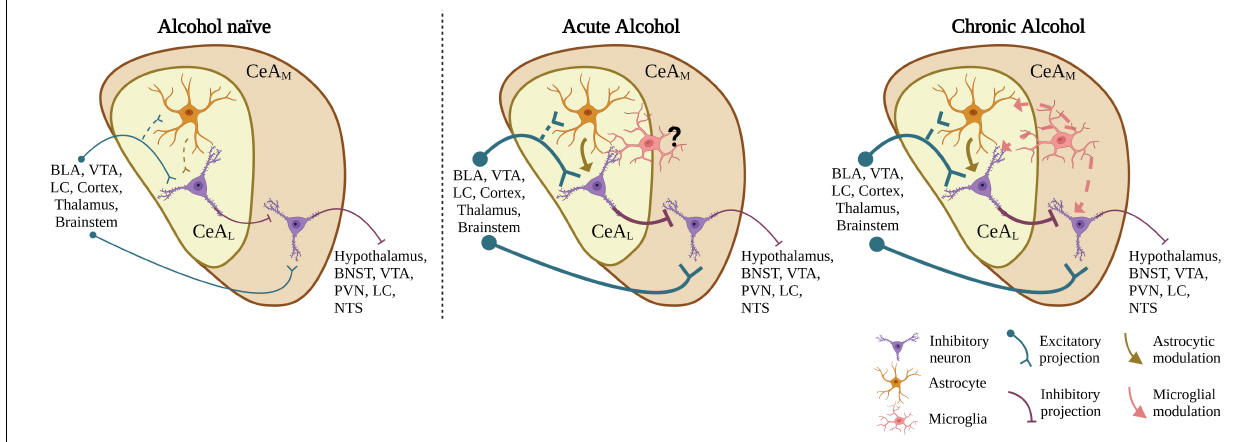
FIGURE 1 | Proposed CeA neurocircuit model and summary alcohol effects on CeA neurotransmission. In alcohol-naive circuitry, the CeA L receives glutamatergic input from various brain regions and sends GABAergic projections to the CeA M . The CeA M , which also receives some direct input from similar regions as the CeA L , in turn sends GABAergic projections to various brain regions. Acute application of EtOH to CeA slices increases glutamatergic neurotransmission in the CeA L , an effect regulated by astrocytic function. We propose the increased glutamatergic release acts on CeA L neurons leading to an increase in GABA release in the CeA M . After chronic alcohol exposure, in addition to astrocytic function, microglia may also play a role in the increase in glutamatergic transmission through upregulation of activated microglial activity. BLA, basolateral amygdala; VTA, ventral tegmental area; LC, locus coeruleus; BNST, bed nucleus of the stria terminalis; PVN, paraventricular nucleus; NTS, nucleus of the tractus solitarius. Created with